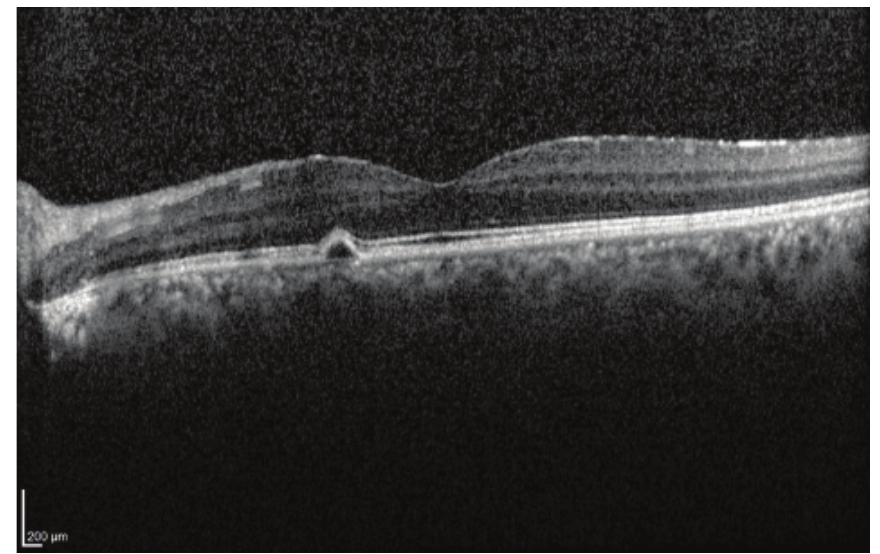
Figure 4. Macular SD-OCT of the same eye two months later shows resolved subretinal fluid.